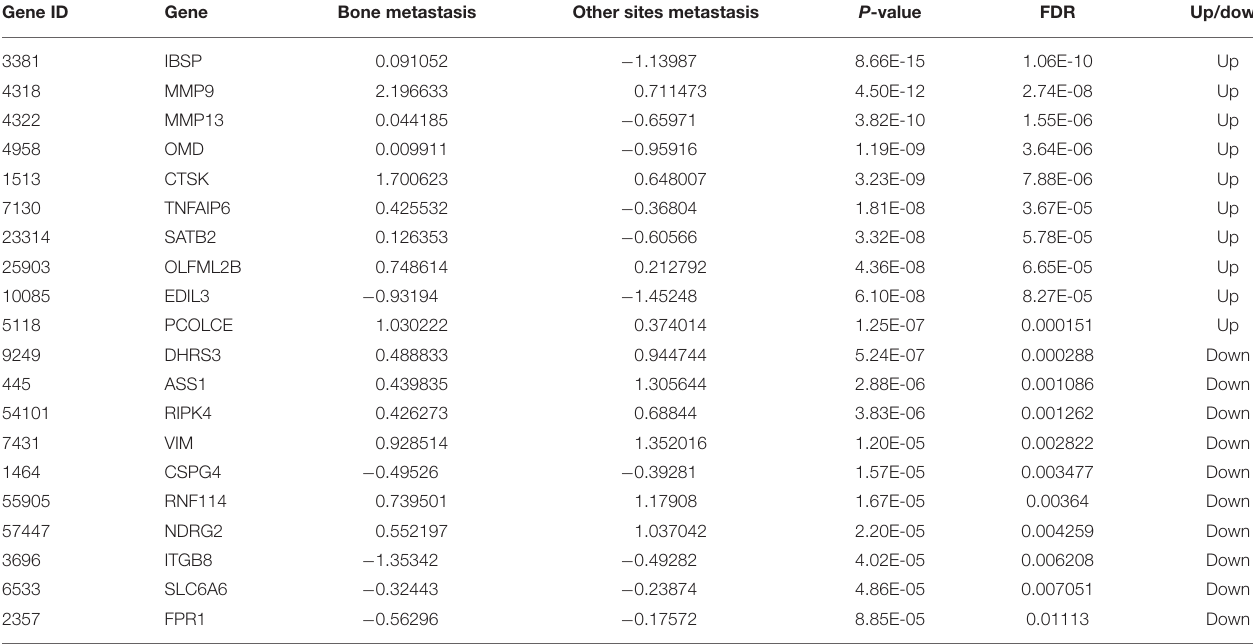
TABLE 2 | Top 10 up- and down-regulated